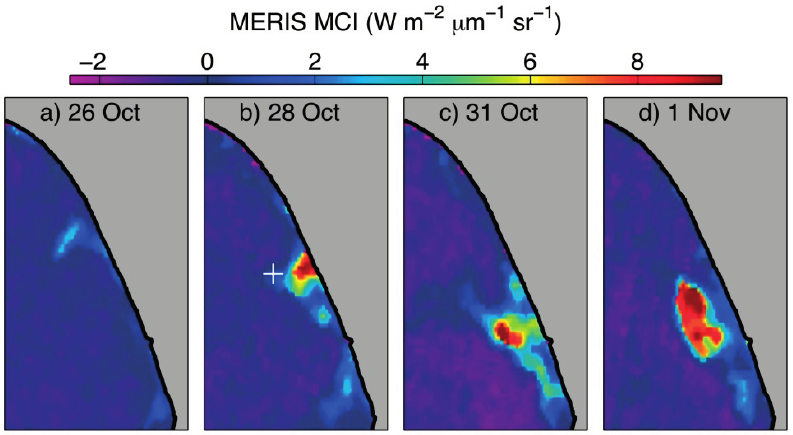
Figure 8. Fall 2011 study: Expansion of the red tide bloom, as described by MERIS MCI. The 26 October image was acquired at 11:28 local time, 4 hours and 5 minutes before the HICO image (Figure 7c). Note the different MCI color scales in comparing Figures 7c and 8a.